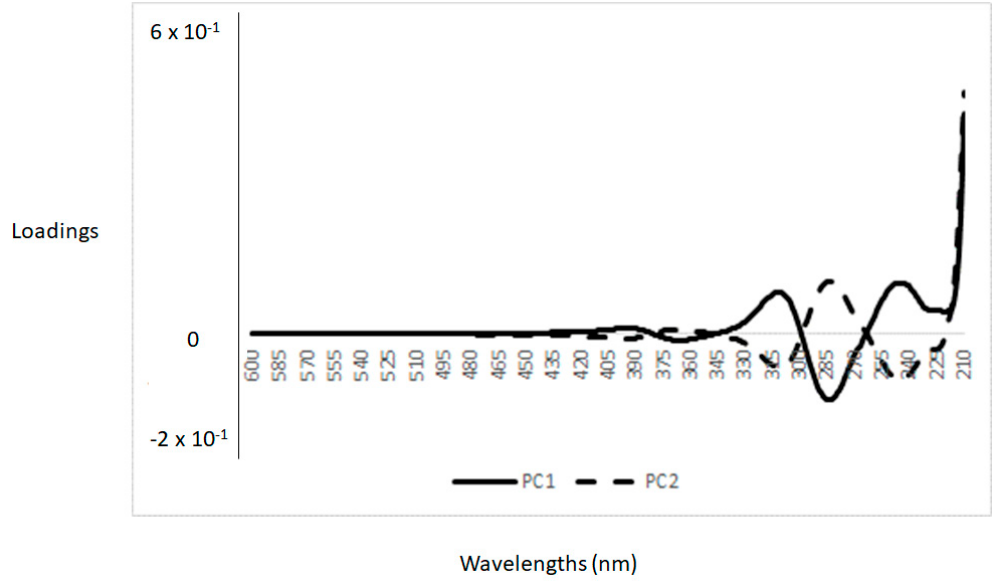
Figure 5. Principal component loadings of whisky samples analysed UV-VIS spectroscopy.